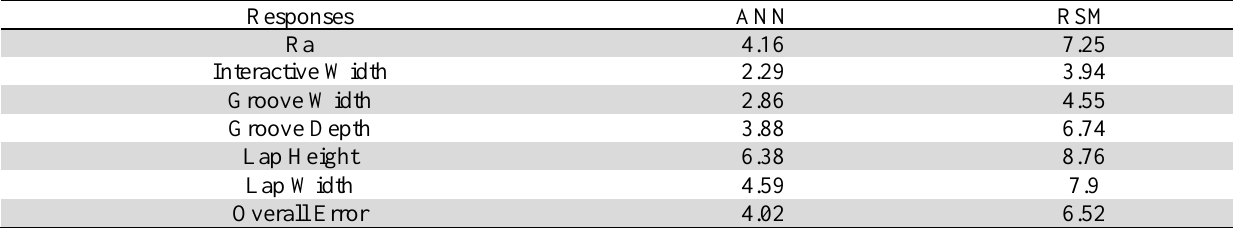
The average Errors for the ANN and RSM